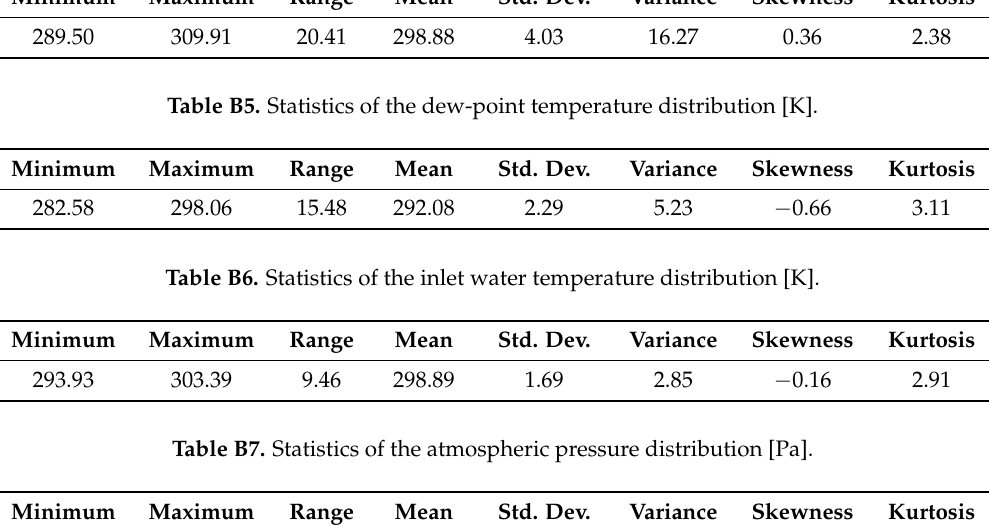
Figure B5. Histogram plot of wind speed data collected by SRNL from F-Area cooling towers.